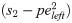
Illustration of converting paired-reads to SNP matrix and SV matrix.(a) Paired-end read r1 and r2 both contain SNPs but r3 does not, therefore, r1 and r2 can be successfully converted to read fragment f1 and f2 respectively. SNP s2 is covered by r2, and the allele at s2 can be obtained by the 4-th (s2-peleft2) nucleotide on r2; (b) Single-end mapped read r1 and r2 whose unmapped ends are overlapping with sv1 (e.g., a deletion), both of M1,1SV and M2,1SV can be assigned by 1.